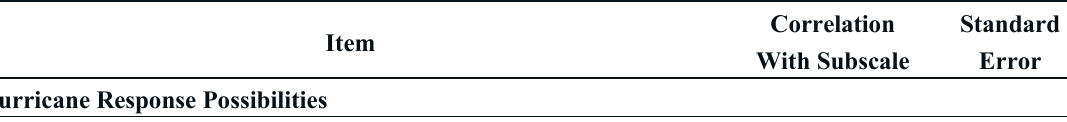
Table 3. Correlations of HPSES Items with their Respective